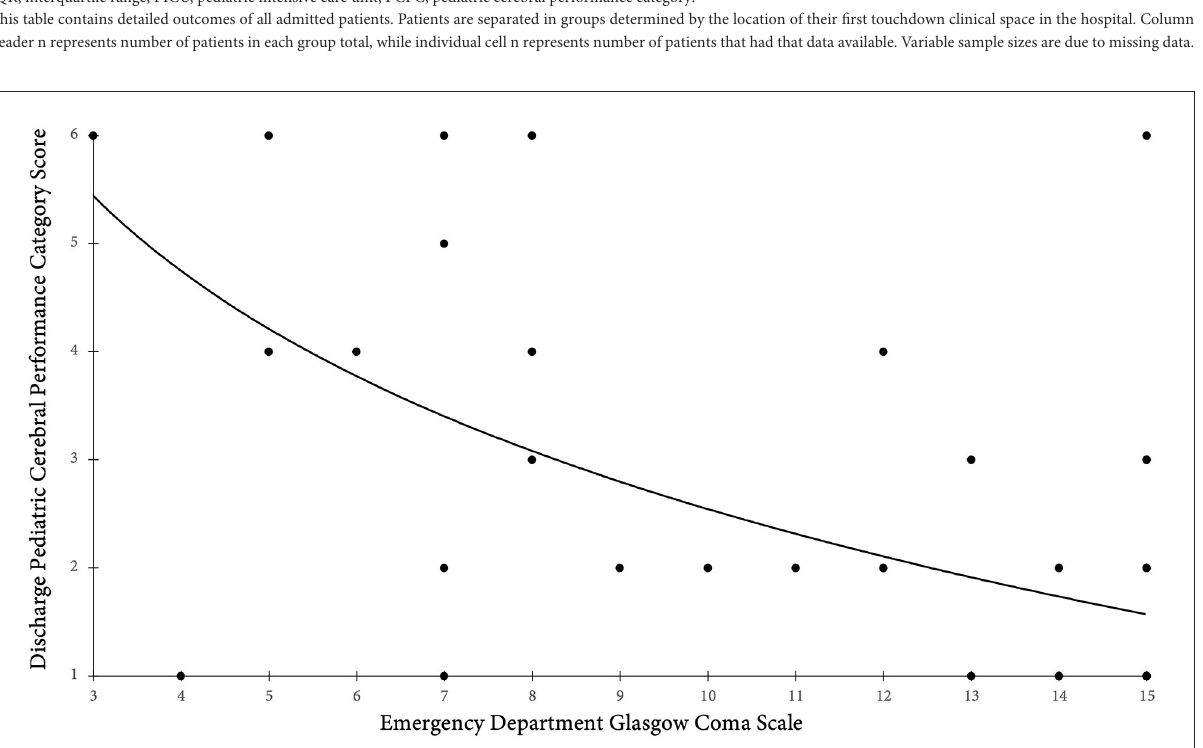
associated with a favorable PCPC score on discharge ( p <